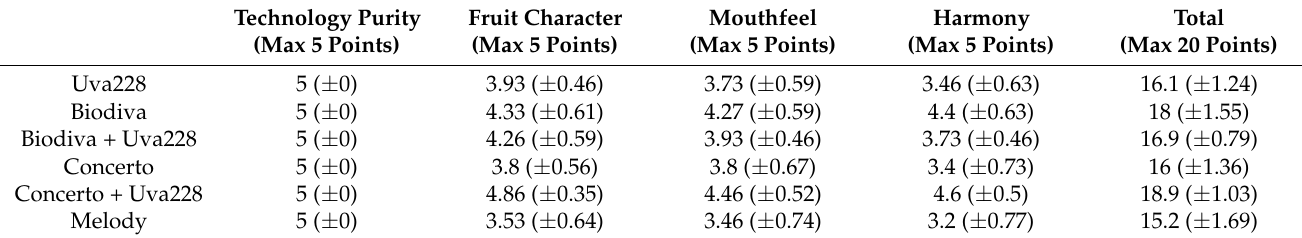
Table 3. Sensory analysis of apple spirits obtained from different starter